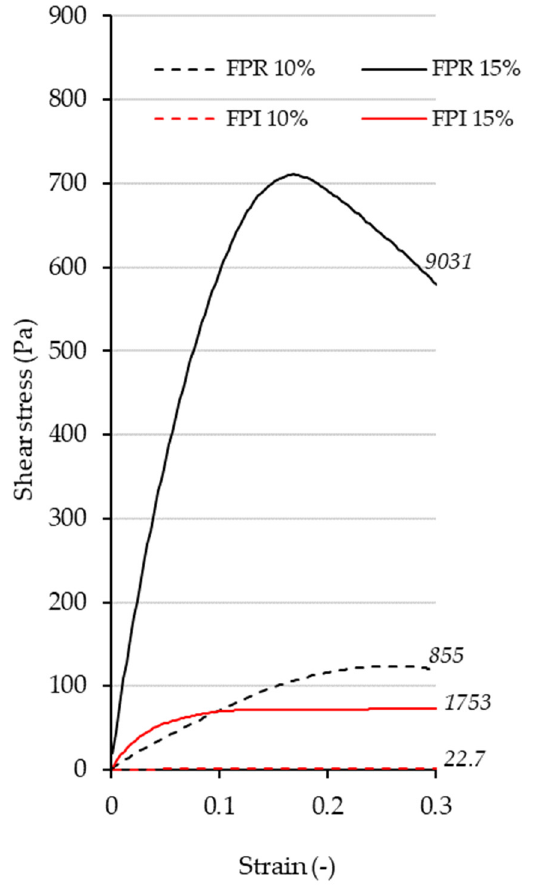
Figure 9. Rotational stress-strain curves for FPR and FPI and 10% and 15% protein with shear stress (Pa) shown as a function of strain (-). Young’s modulus (Pa) is shown for each curve in italics.